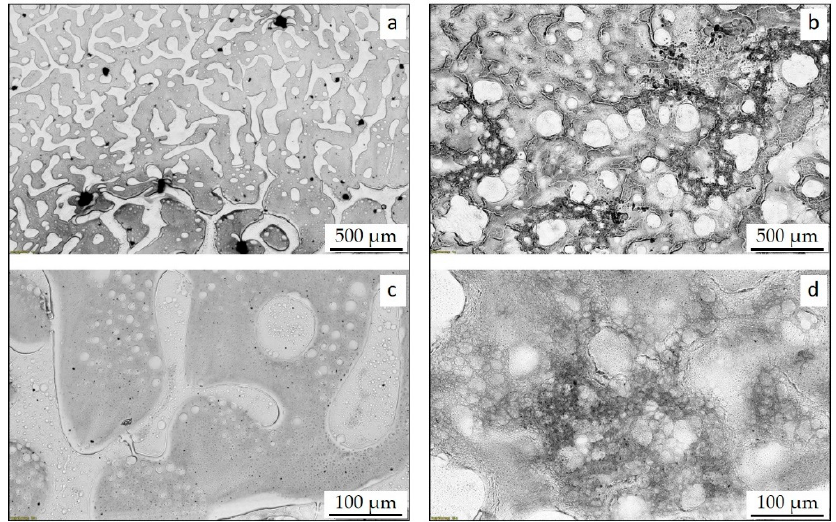
Figure 6. TLM images of PS / PB blends with 1 wt % of CNT-C18 dispersed in toluene ( a , c ) and chloroform ( b , d ) prepared on glass substrates; ( c , d ) at higher magnification.